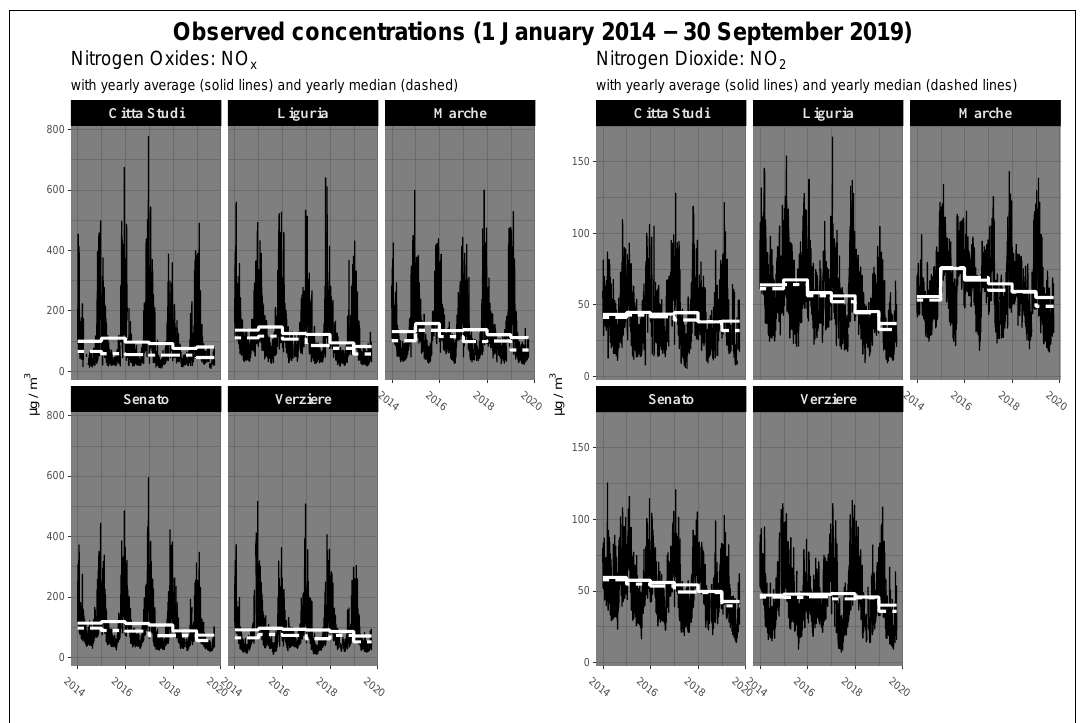
Figure 4. Pollutant levels in Milan ( µ g/m 3 ). Observed concentrations levels of NO x and NO 2 between 2014 and 2019 with yearly average and median values. Values are expressed as µ g/m 3